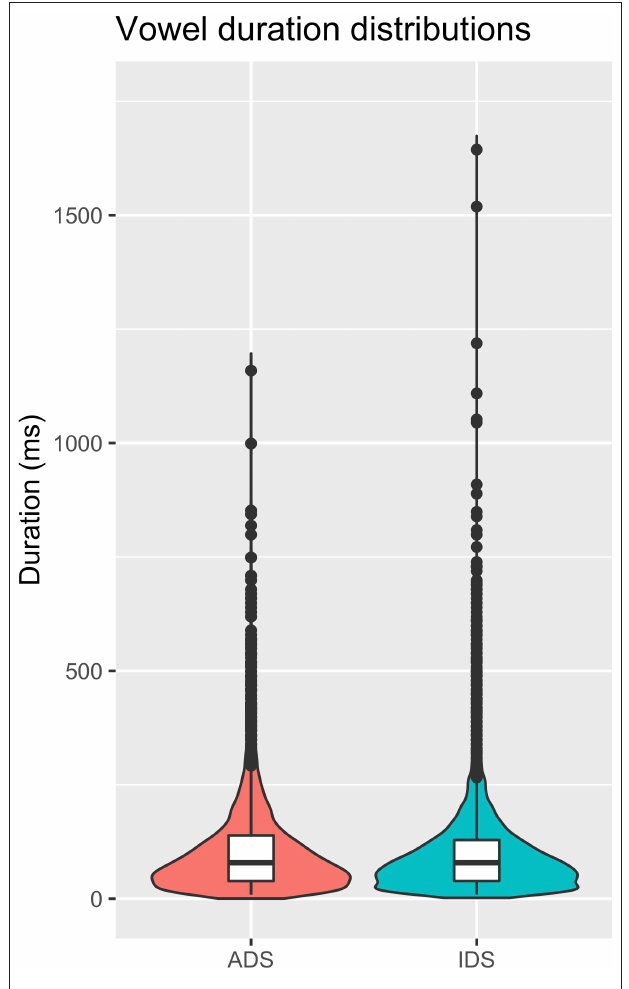
FIGURE 6 | Duration medians and quartiles in ADS and IDS, all vowel tokens from all participants.